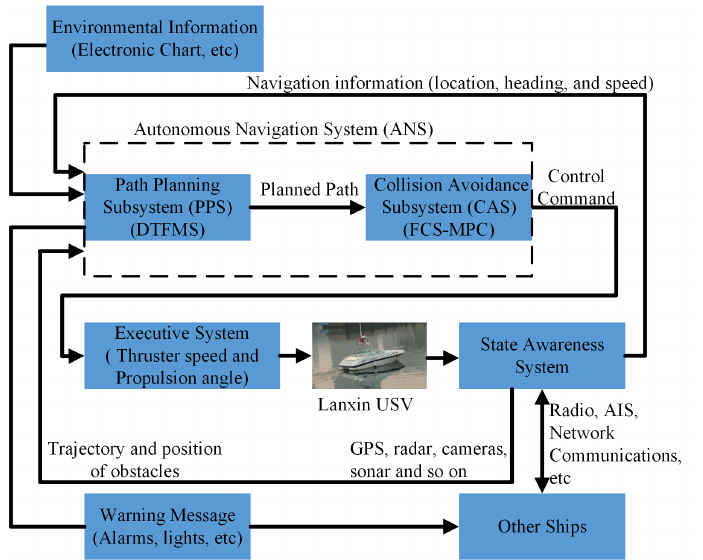
Figure 1. The overall structure of the unmanned surface vehicle (USV) system. DTFMS: dynamic domain tunable fast marching square; FCS-MPC: finite control set model predictive control; GPS: global positioning system; AIS: automatic identification